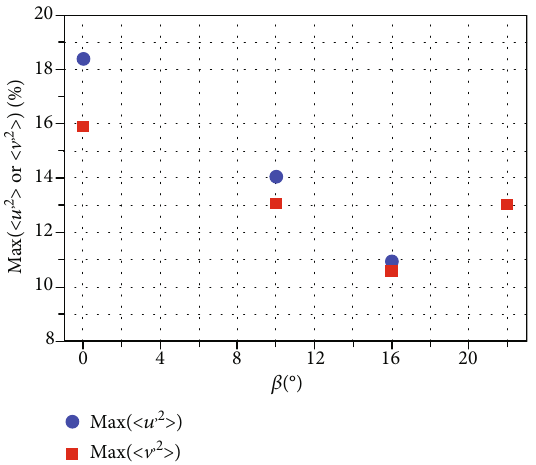
Figure 12: Maximum turbulence levels at di ff erent boattail